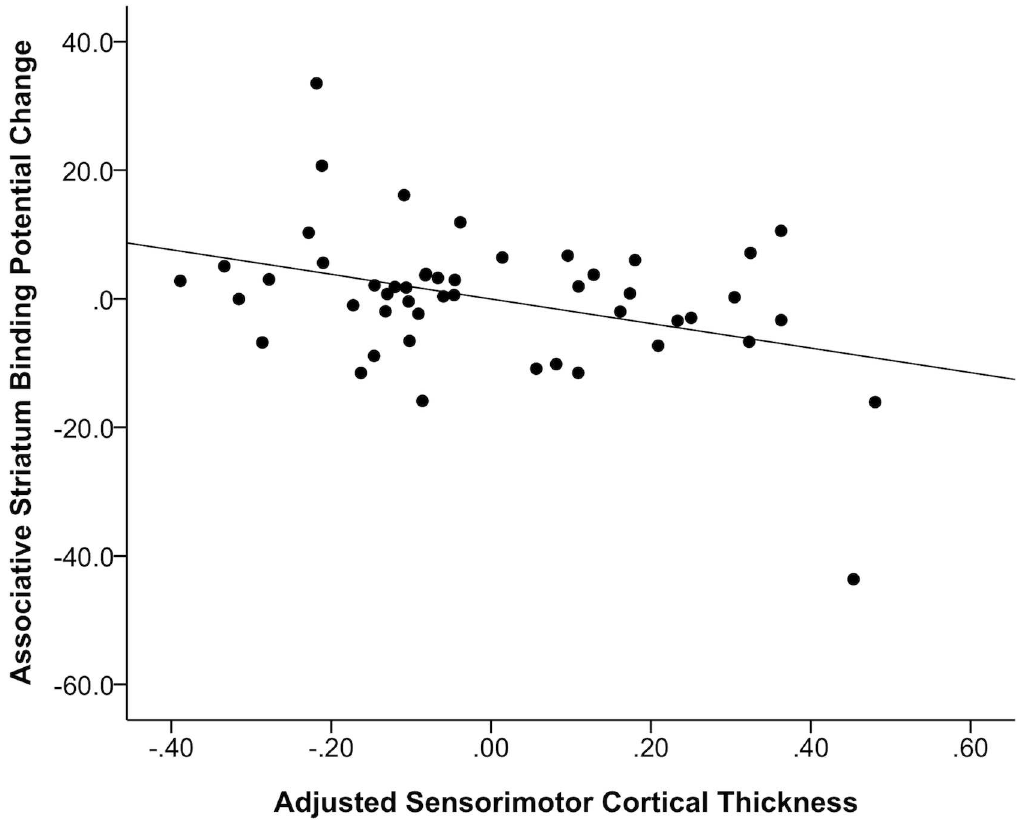
Fig 5. Partial correlations between associative striatal dopamine releaseand sensorimotor cortical thickness, controlling for age and gender. Correlation between the residualsfrom regressingchangein binding potentials (% Δ BP ND ) in the associative striatum on age and gender, and the residuals from regressing adjusted sensorimotor cortical thickness on age and gender.